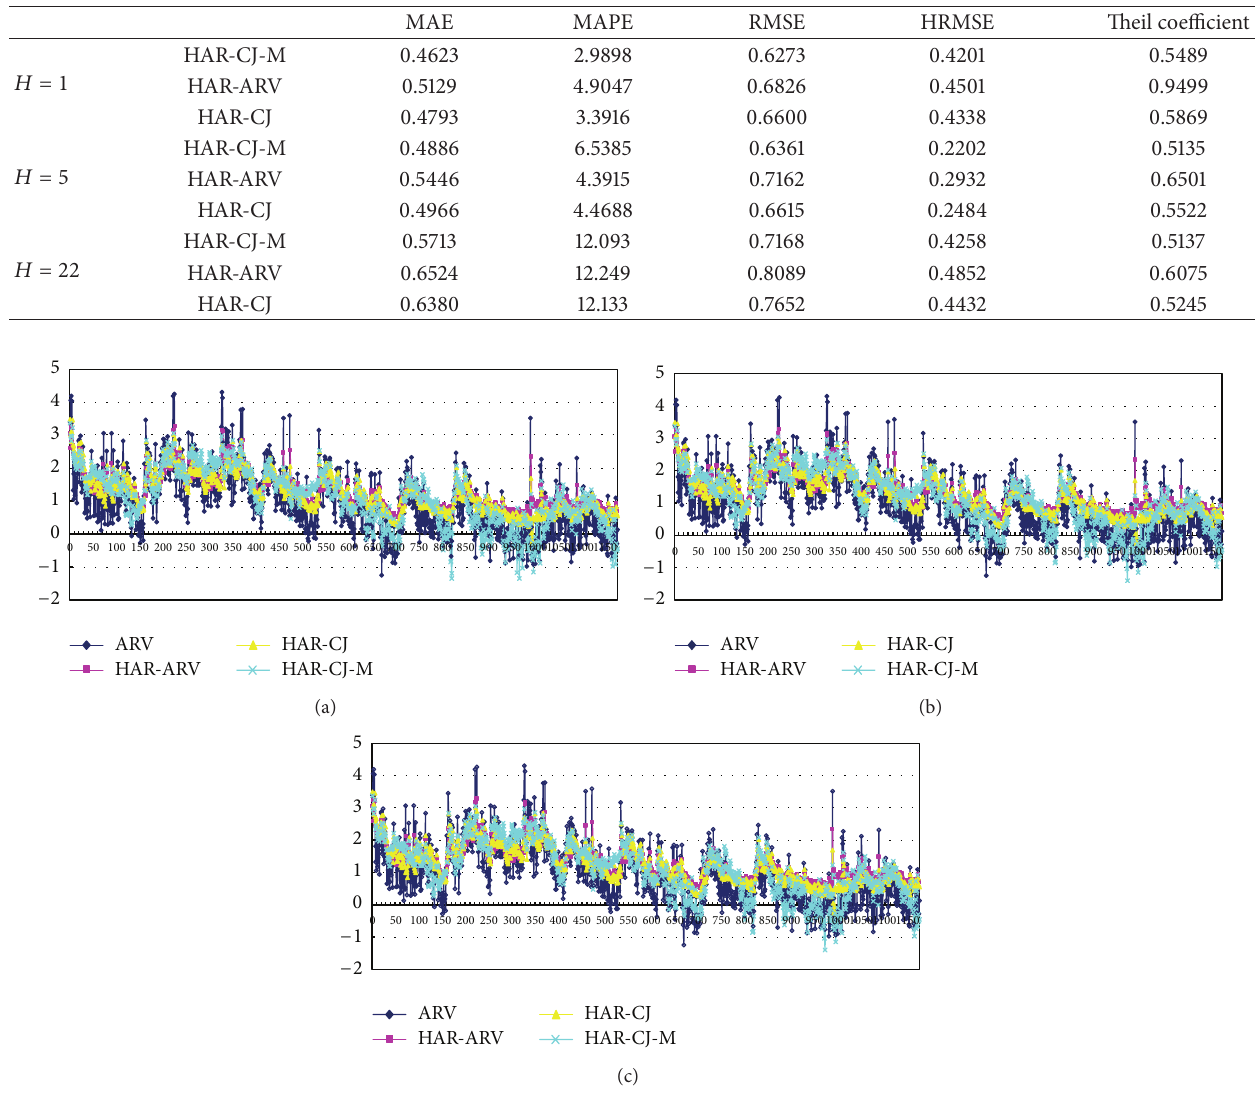
Figure 2: (a) Comparison of the in-sample forecasting performance of the HAR-ARV, HAR-CJ, and HAR-CJ-M models (1 day). ARV represents the true volatility; HAR-ARV, HAR-CJ, and HAR-CJ-M represent the forecast volatility of the HAR-ARV, HAR-CJ, and HAR- CJ-M models, respectively. (b) Comparison of the in-sample forecasting performance of the HAR-ARV, HAR-CJ and HAR-CJ-M model (1 week). ARV represents the true volatility; HAR-ARV, HAR-CJ, and HAR-CJ-M represent the forecast volatility of the HAR-ARV, HAR-CJ, and HAR-CJ-M models, respectively. (c) Comparison of the in-sample forecasting performance of the HAR-ARV, HAR-CJ, and HAR-CJ-M model (1 month). In the figure, ARV represents the true volatility; HAR-ARV, HAR-CJ, and HAR-CJ-M represent the forecast volatility of